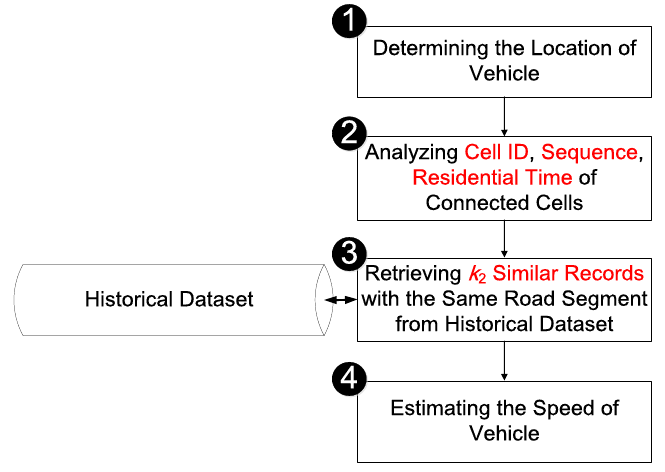
Figure 4. The steps of speed estimation method.